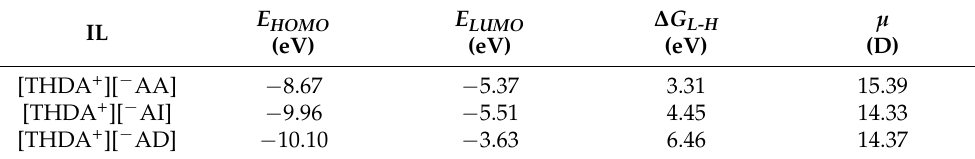
Table 7. IL quantum parameters at the B3LYP/6-311G level in aqueous medium.